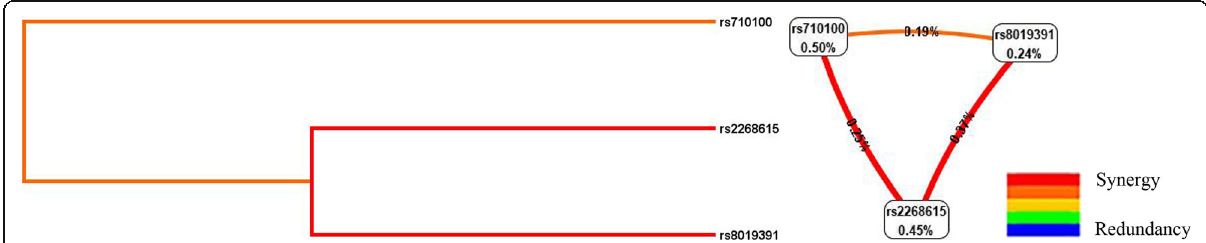
Fig. 2 SNP-SNP interaction dendrogram and Fruchterman-Reingold